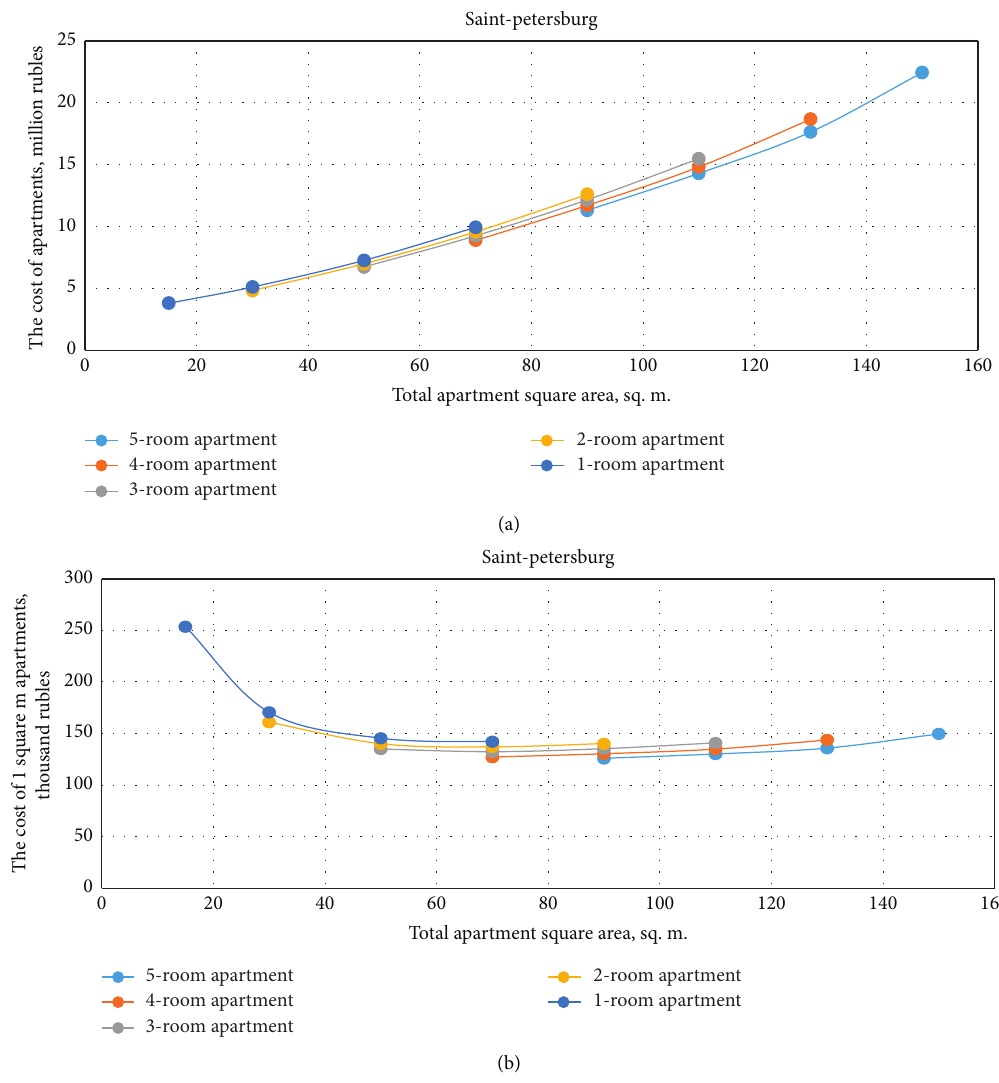
Figure 5: Influence of the square area of St. Petersburg apartments on their cost (a) and on the specific cost of one square meter